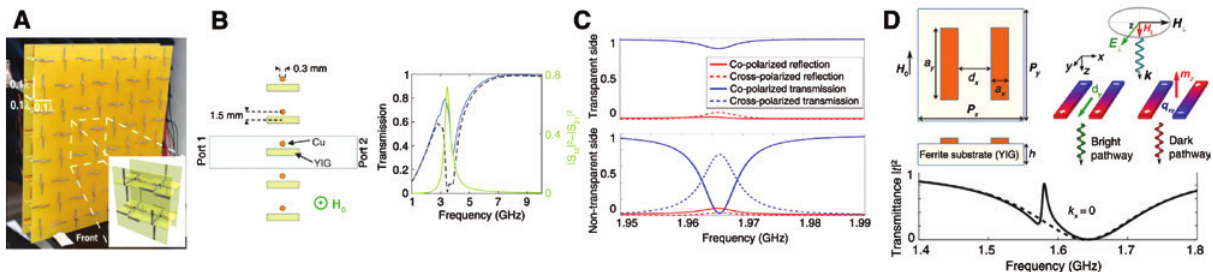
Figure 11: Metasurfaces exhibiting nonreciprocal anisotropic and bianisotropic effects. (A) A photo of anisotropic magnet-less metasurface exhibiting the Faraday rotation. Reprinted figure from [191]. Copyright (2012) by United States National Academy of Sciences. (B) Left: Schematic of nonreciprocal metasurface with pure artificial moving coupling. Right: Transmis- sion spectra when the structure is illuminated from the left (| S | 2 , dashed black curve) and from the right (| S | 2 , blue curve). Reprinted 21 12 figure from [193]. Copyright (2014) by the American Physical Society. (C) Simulated reflectance and transmittance spectra for a metasurface with ferrite inclusions shown in Figure 4B. The top and bottom plots correspond to the two opposite illumination directions. Reprinted figure from [101]. Copyright (2014) by the American Physical Society. (D) Top: Geometry of a bianisotropic metasurface exhibiting the effect of = 0) and “dark” (solid line; H ≠ 0) gyromagnetically induced transparency. Bottom: Transmittance spectra for the “bright” (dashed line; H 0 0 modes. Reprinted figure from [194]. Copyright (2014) by the American Physical